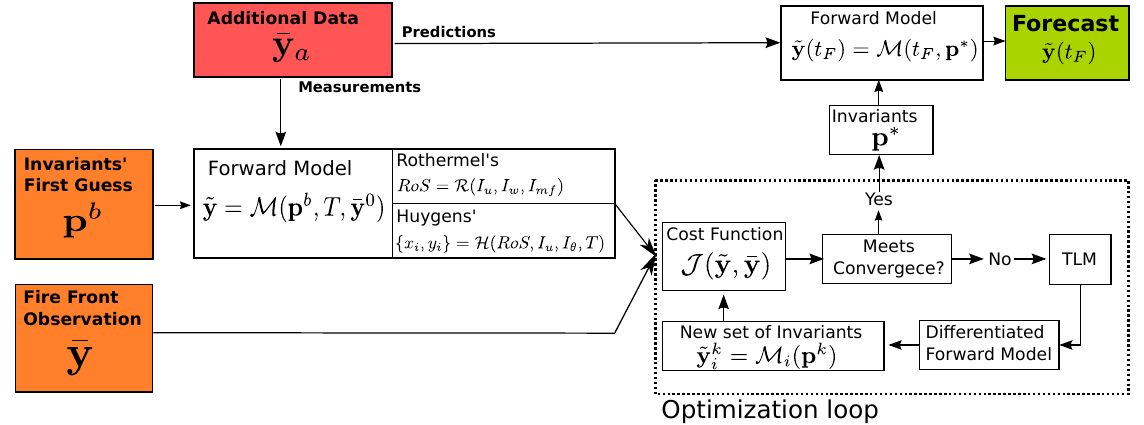
Figure 2. Program structure flow diagram. Orange boxes are the required inputs, green box is the output and red box shows additional inputs.